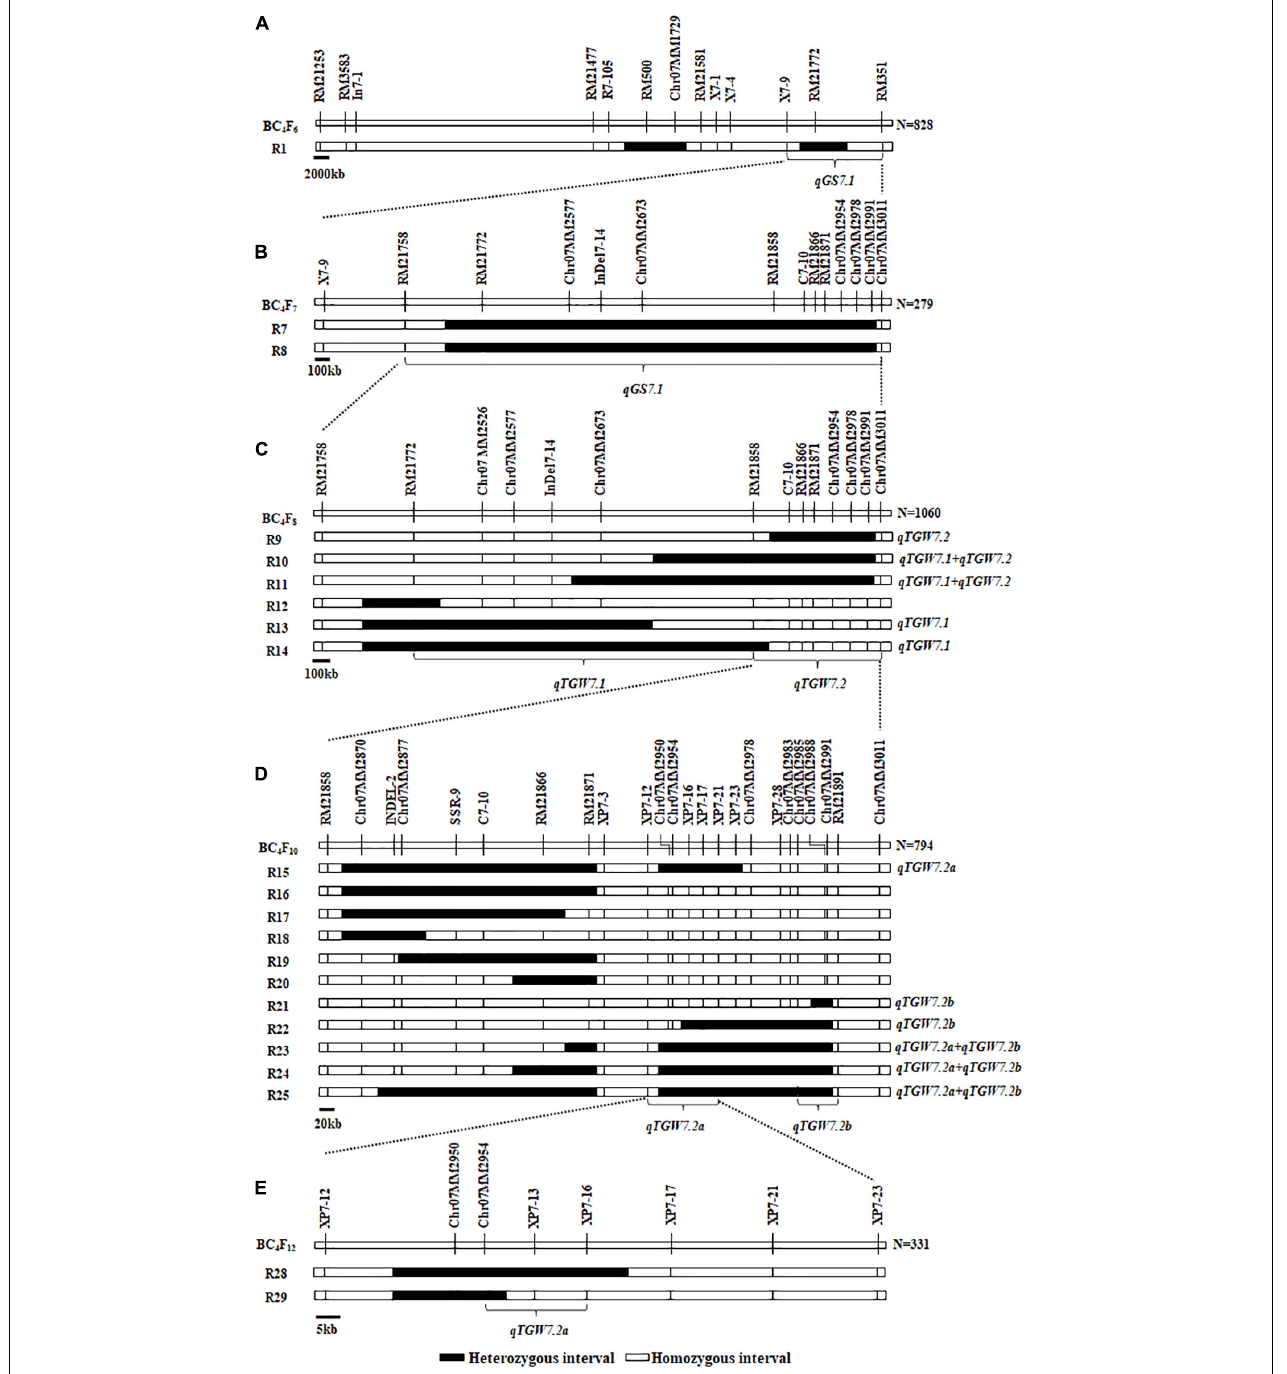
FIGURE 1 | Genotypic compositions of residual heterozygous populations in the target regions. (A) Composition of R1 population in previous study. (B) Two residual heterozygous populations in BC 4 F 7 . (C) Six residual heterozygous populations in BC 4 F 8 . (D) Eleven residual heterozygous populations in BC 4 F 10 . (E) Two residual heterozygous populations in BC 4 F 12